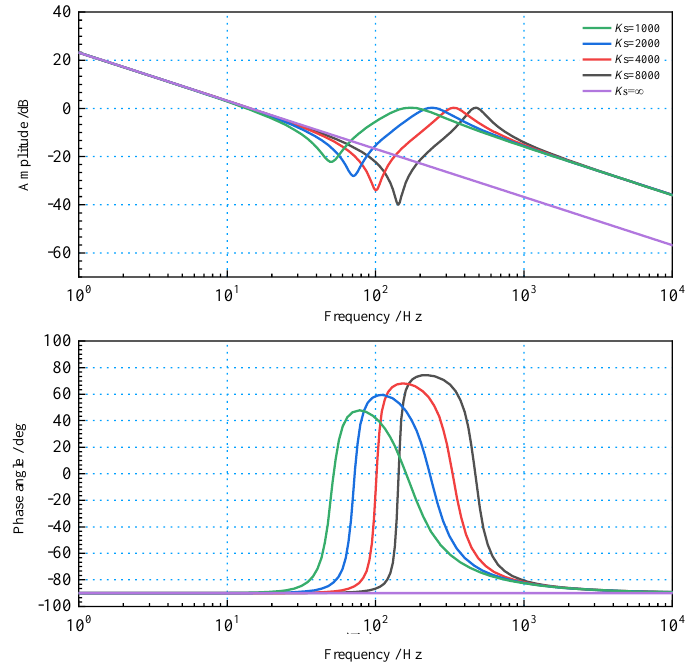
Figure 16. Bode diagram of rotor shafting stiffness characteristics.